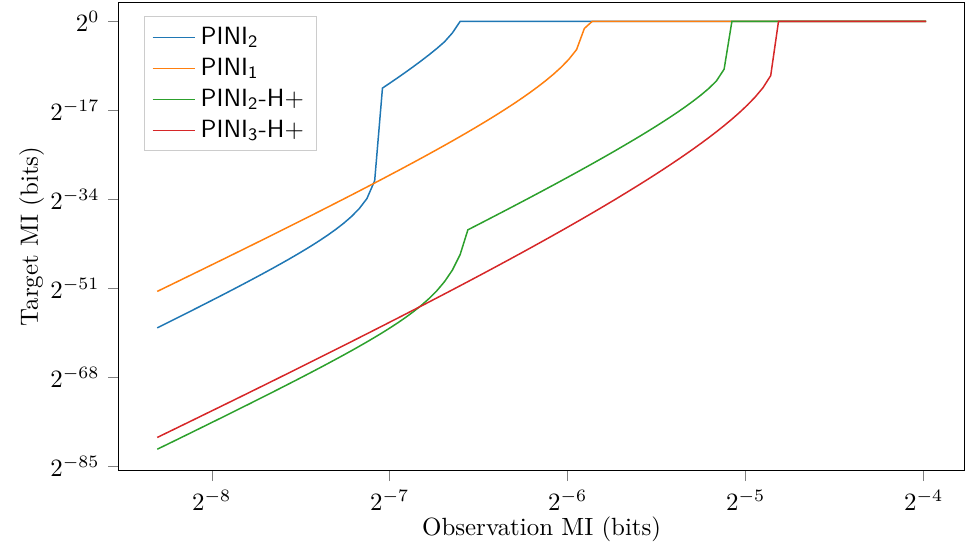
Figure 7: Target MI as a function of observation MI, for various PINI multiplication gadgets at order t =